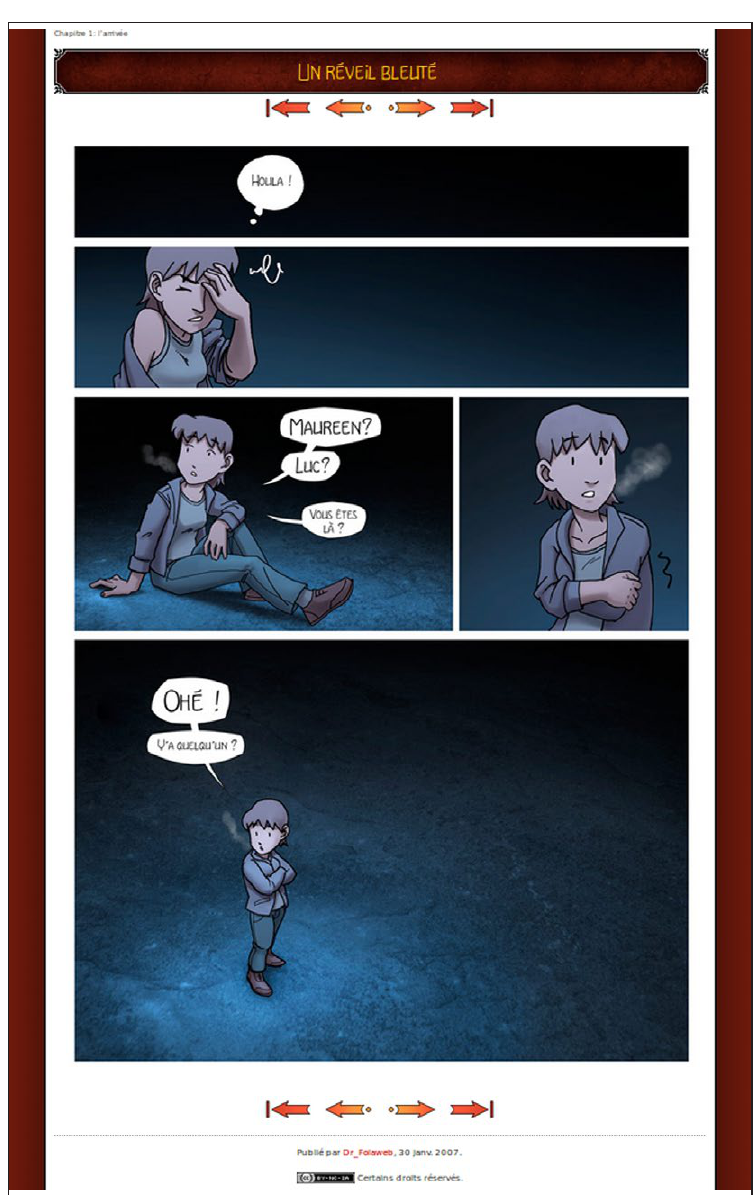
Figure 4: Example of a comic distributed in ‘page’ format, presented here with its reading environment. Dr Folaweb, Deo Ignito , Webcomics.fr, 2007–2015,